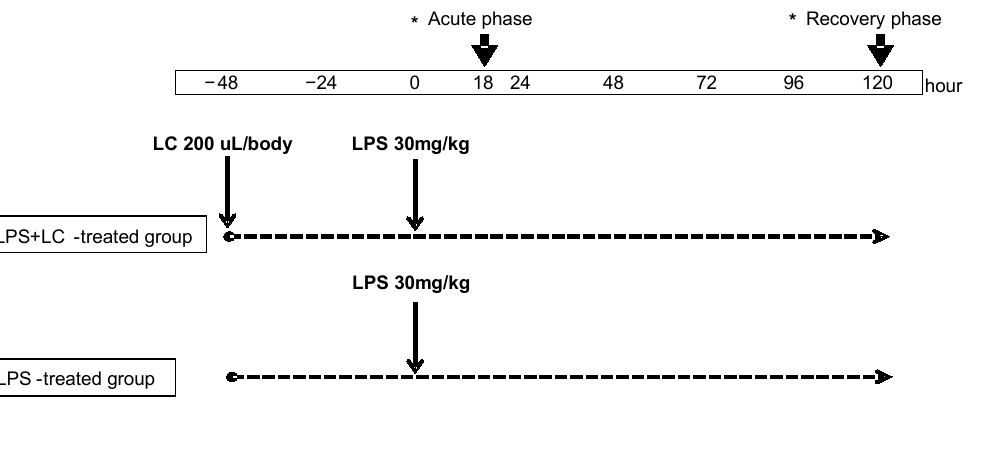
Figure 1. Experimental protocol. At 48 h, mice were given either liposomal clodronate (LC) or saline by an intrapertoneal injection. At 0 h, a total of 40 C57BL/6 mice were injected intraperitoneally (i.p.) with 30 mg/kg of lipopolysaccharide (LPS). Mice were culled at 18 ( n = 10 each) and 120 h ( n = 10 each). Specimens were collected each hr. Asterisks indicate when specimens were collected.